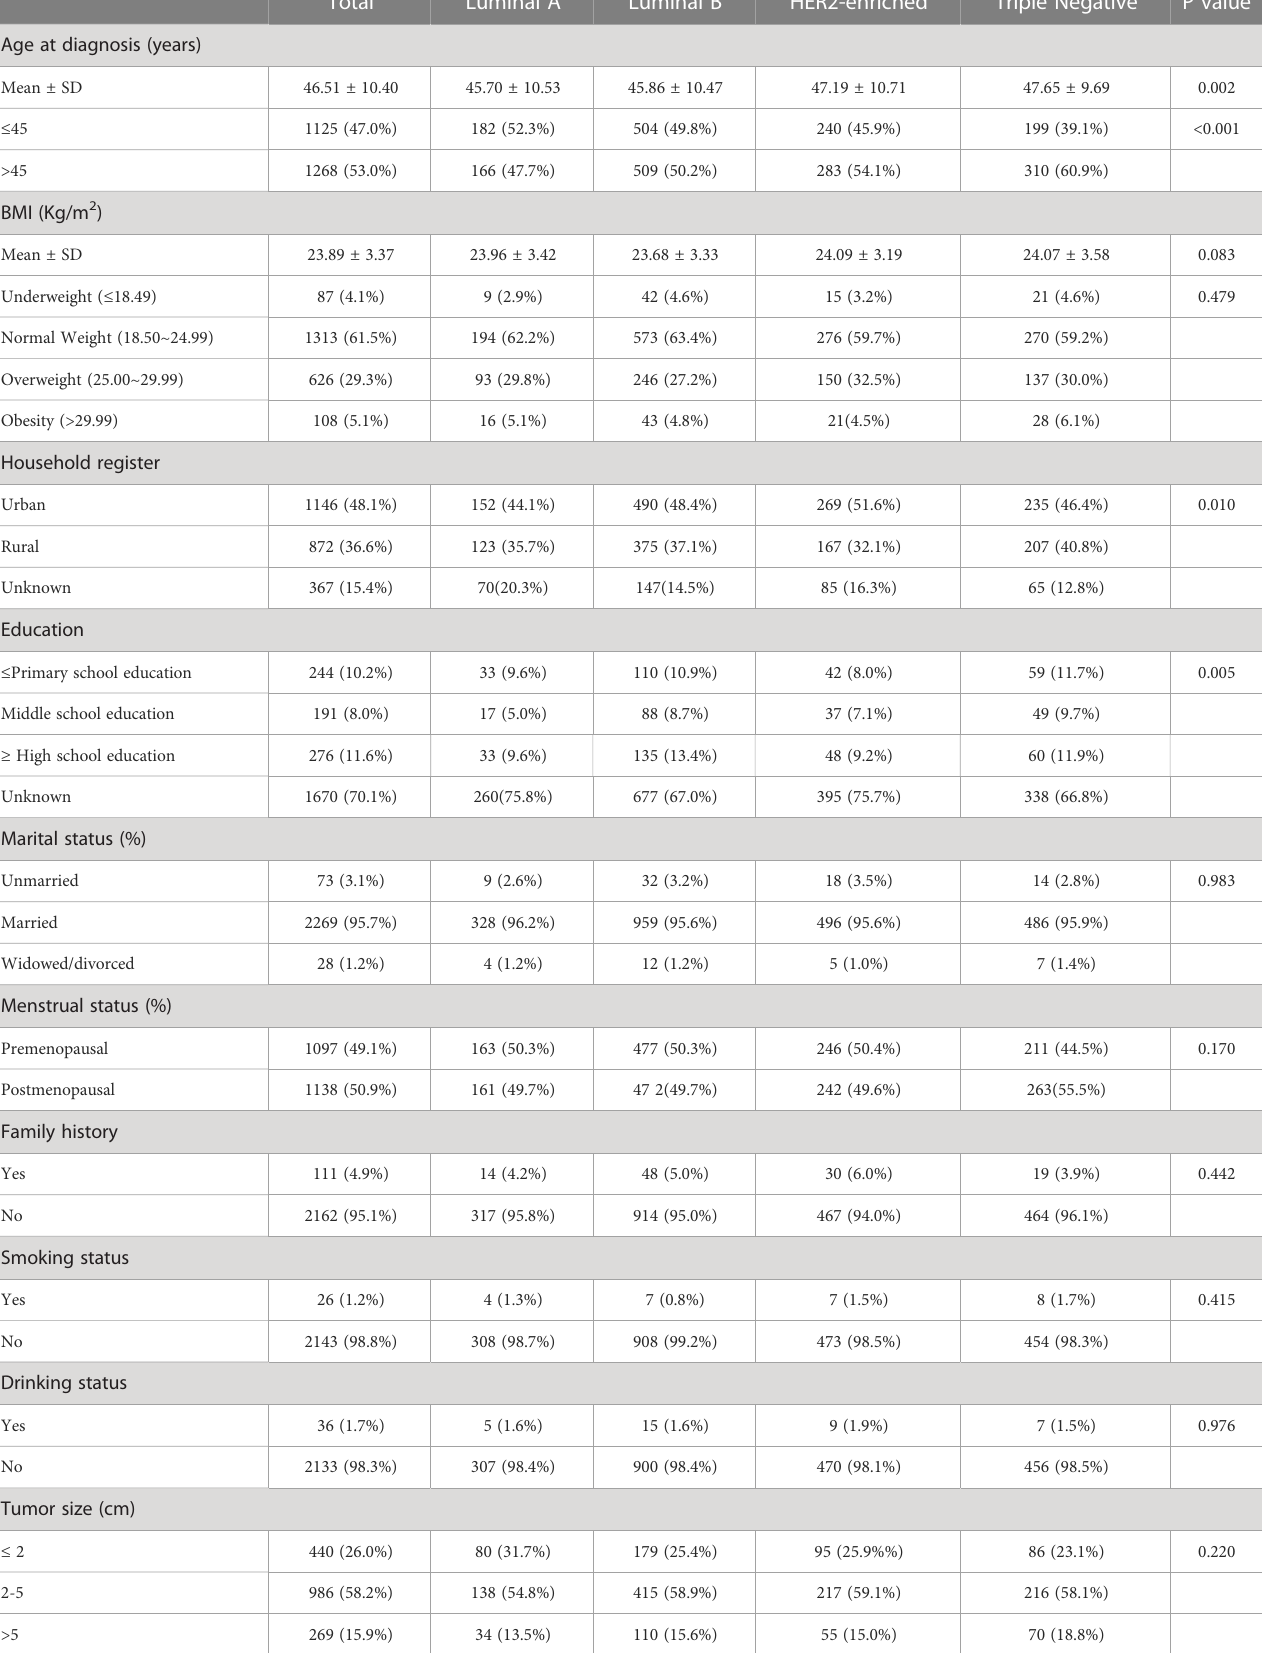
TABLE 1 Clinicopathological characteristics of ABC patients according to molecular